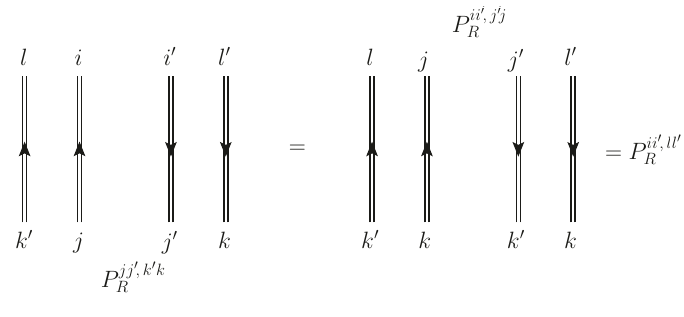
Figure 8. Simplification in the extended soft factor S qq with all Wilson lines at the same transverse position, using the identity in figure 2 and the unitarity of Wilson lines. Analogous relations hold for indices in the adjoint colour